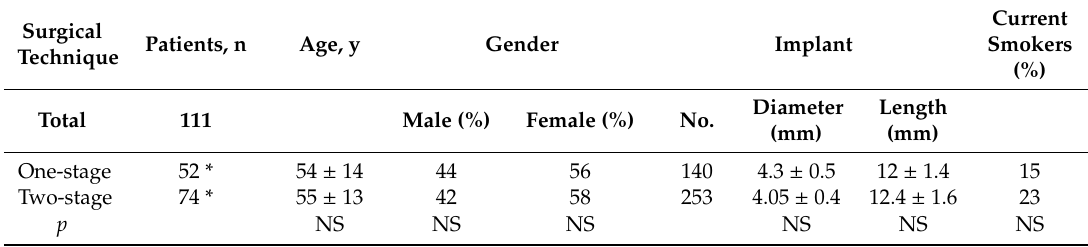
Table 1. Demographic and implant-related